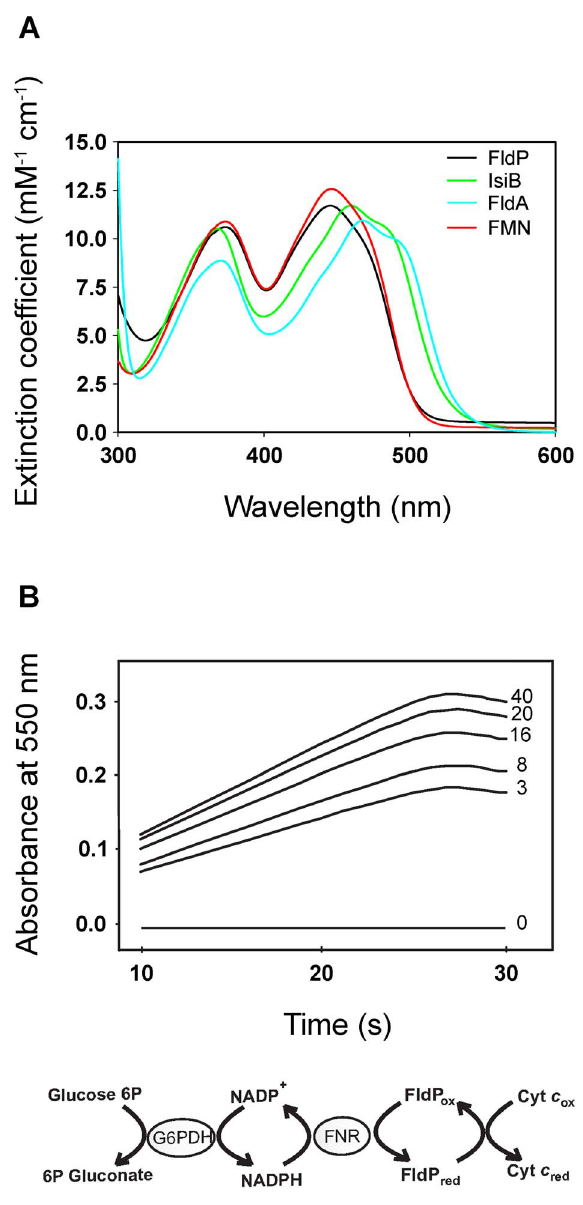
Figure 2. FldP from P.aeruginosa is a functional flavodoxin. The FldP holoprotein was expressed in E. coli and purified by affinity chromatography as described in Materials and Methods. ( A ) Visible absorption spectra of purified FldP (black), FldA (blue), IsiB (green) and FMN (red) in 50 mM Tris-HCl pH 8.5. ( B ) Kinetics of cytochrome c reductase activity as determined by the increase in absorbance at 550 nm. Numerals on the side of each curve indicate FldP concentration (in m M) in the reaction medium. The Fld-driven reaction sequence is indicated at the bottom. Experimental conditions are given in the text.